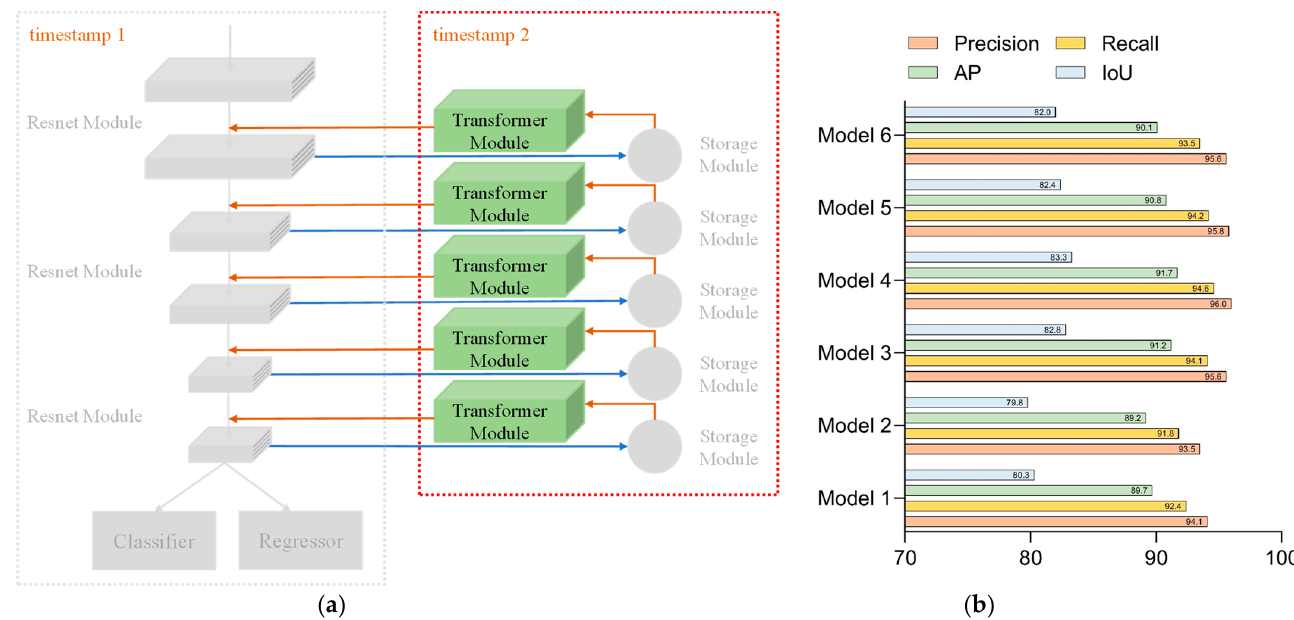
Figure 10. Network 3: ( a ) configuration of Network 3 and ( b ) test results for each parameter of Network 3.